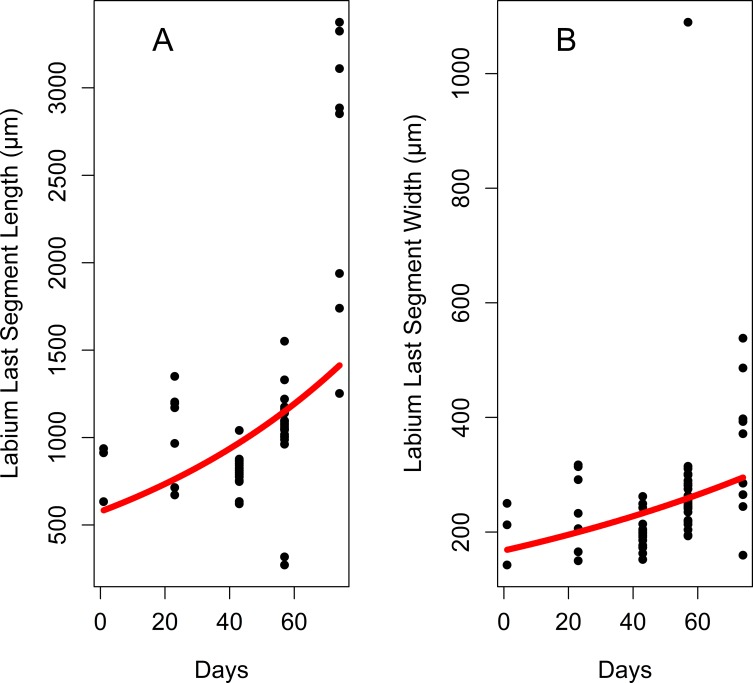
Growth curves for the last labial segment during the lanternfly development.(A) Last segment length, exponential model (y = 572.49e0.01x, R2 = 0.21). (B) Last segment width, exponential model (y = 167.33e0.007x, R2 = 0.16). Axis labels: Day, days of the lanternfly development; day 0, hatching of the 1st nymphal instar; day 74, appearance of the adults (based on dates reported in Dara et al. [8]).